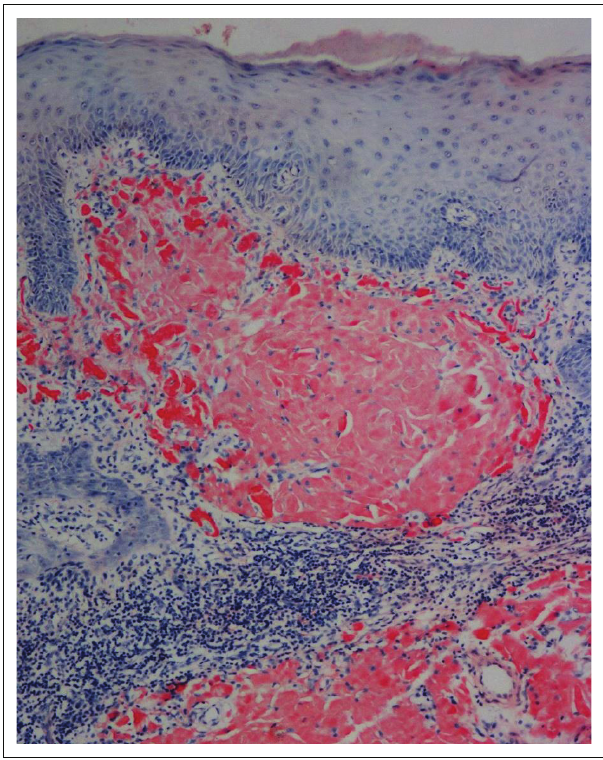
FIGURE 2: Photomicrograph showing typical amorphous extracellular Congo red–positive amyloid deposition within the dermis (Congo red,